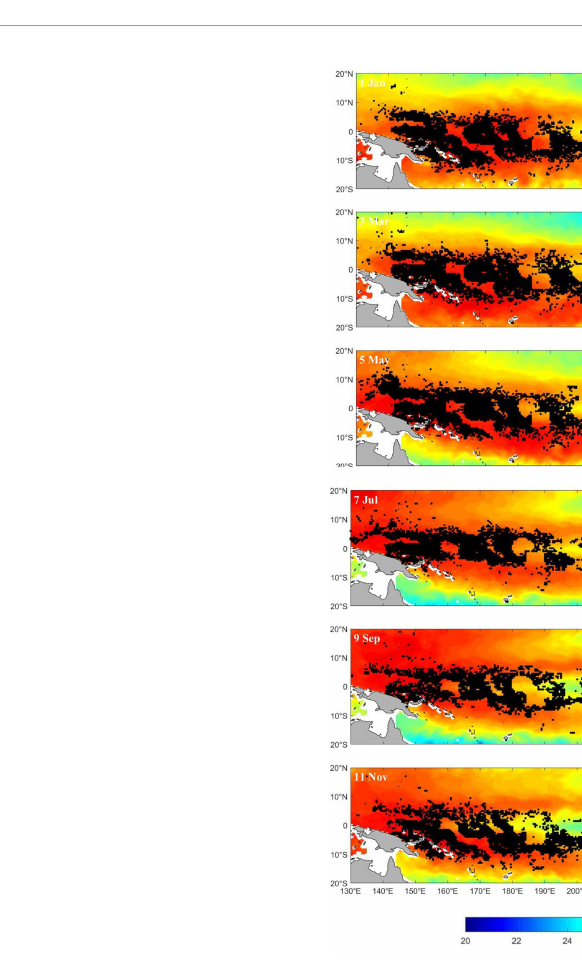
FIGURE 2 | Spatial distribution of tuna purse